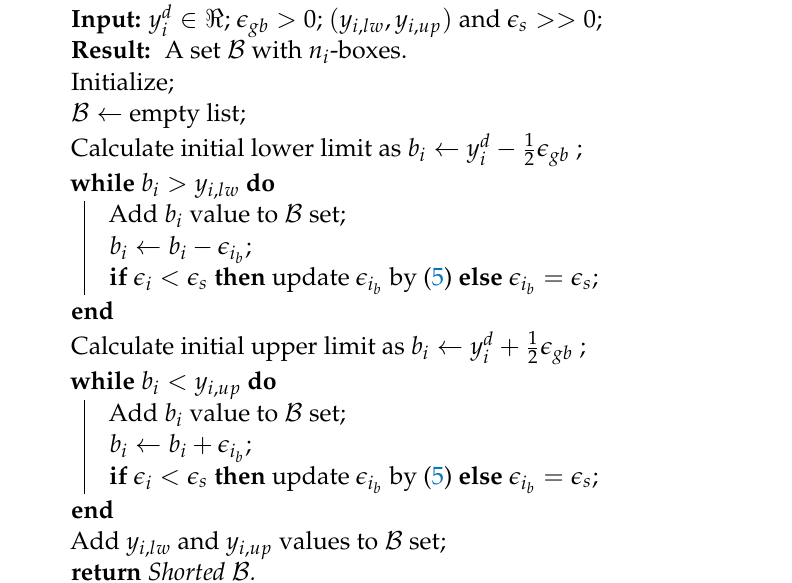
Algorithm 1 The proposed variable box method enables higher resolution near the goal but lower resolution away from it to avoid exploiting dimensionality.